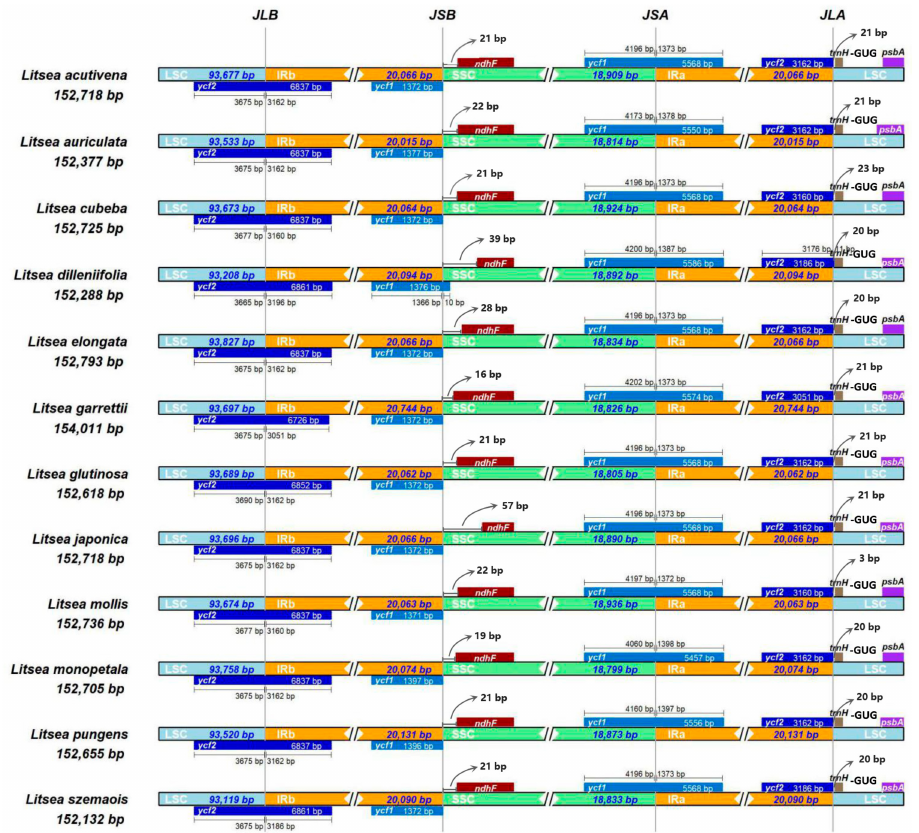
Figure 3. Comparison of the borders of the IR, SSC, and LSC regions among 12 chloroplast genomes of Litsea . JLB, JSB, JSA, and JLA represent the junctions of LSC/IRb, IRb/SSC, SSC/IRa, and IRa/LSC,